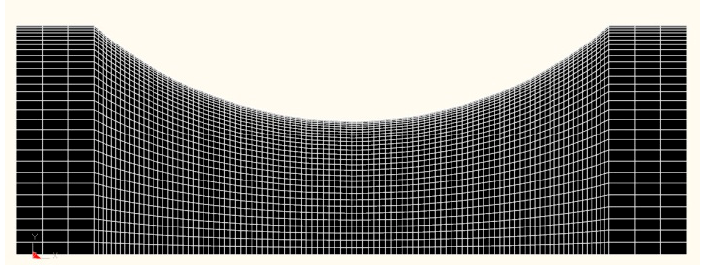
Figure 6. Finite element model of the specimen in notch area.